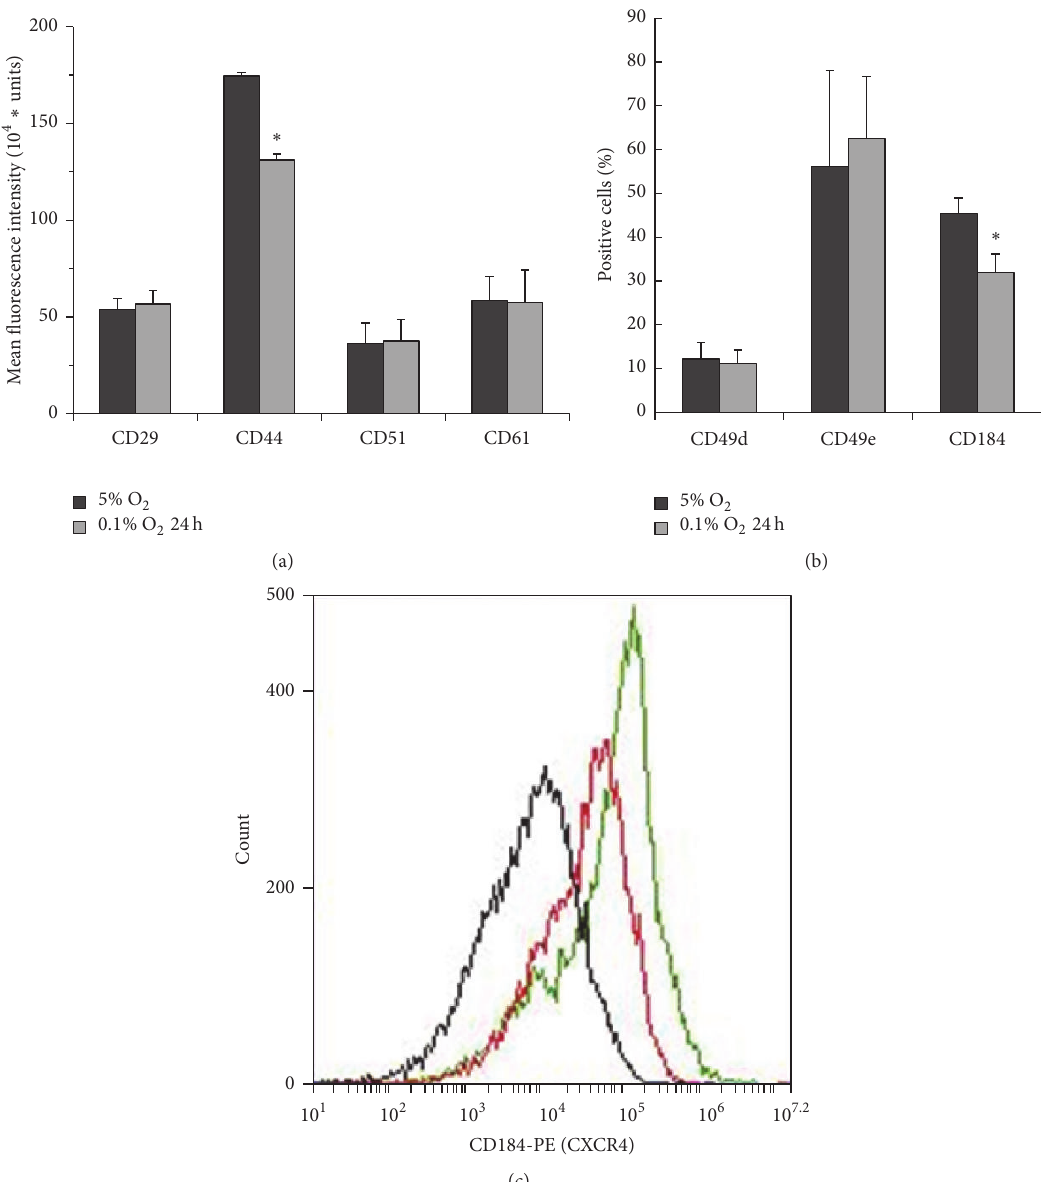
Figure 6: Comparative analysis of the expression of adipose tissue-derived mesenchymal stromal cell (ASC) surface antigens under physioxia and hypoxic stress. Flow cytometric data are presented as (a) mean fluorescence intensity of antigen staining (100% of ASCs were positive) or (b) the percentage of positively stained cells (mean + standard deviation, ∗ 𝑝 < 0.05 ). (c) The surface expression of CXCR4 on ASCs under hypoxic stress (0.1% O 2 ). The black line indicates the isotype control, the green line indicates tissue O 2 -adapted ASCs, and the red line indicates ASCs after short-term hypoxic stress. Data are representative of three independent